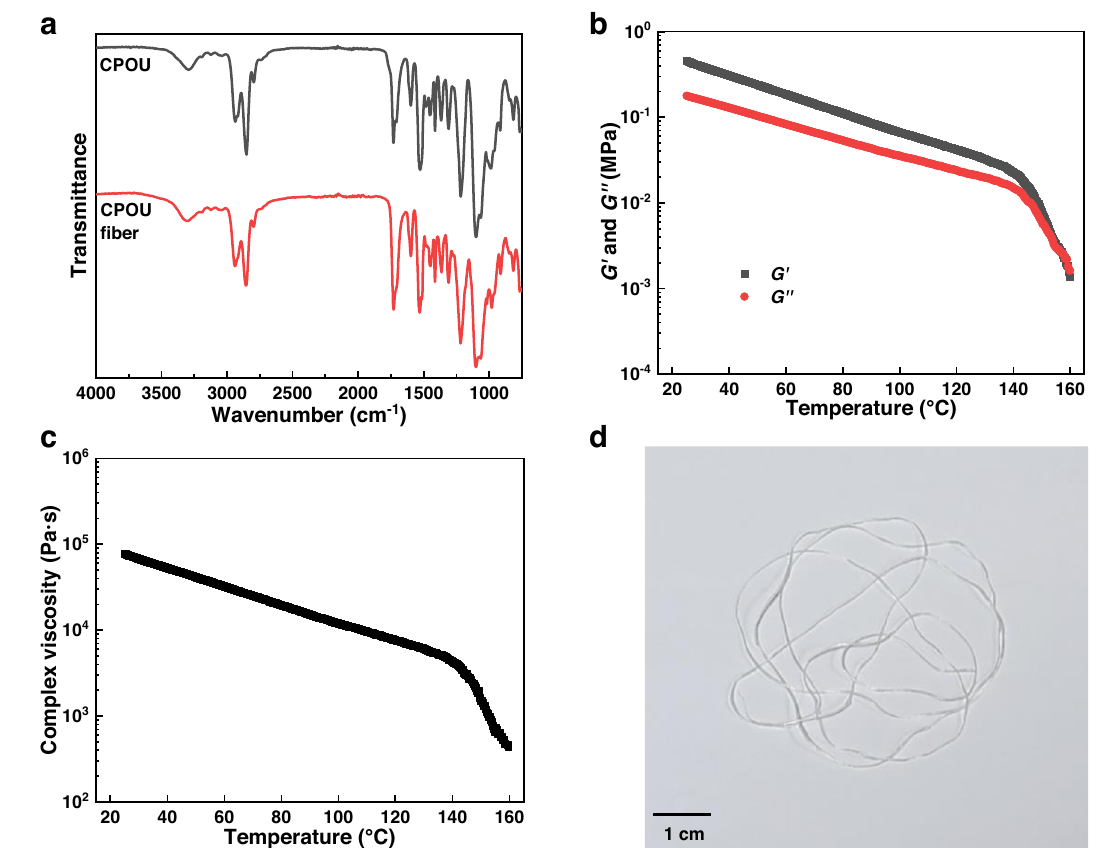
Fig. 2 | Spinnability of CPOU. a FTIR spectraof as synthesized CPOU and CPOU fi ber. b Temperature-dependent curves of storage modulus and loss modulus of CPOU. c Temperature-dependent curve of complex viscosity of CPOU. d Photograph of CPOU fi